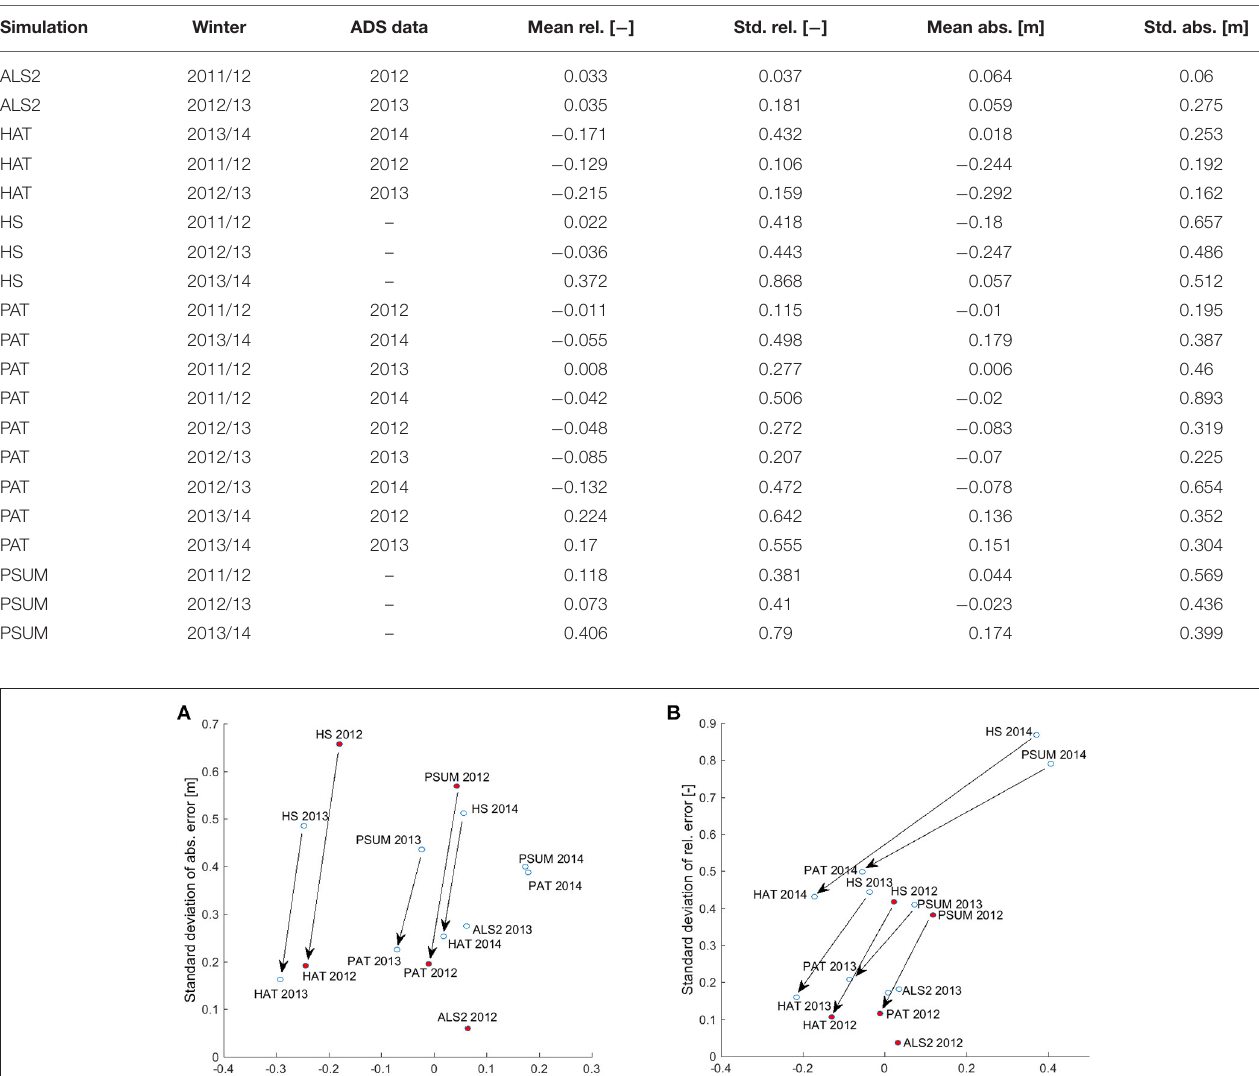
TABLE 2 | Overview on the statistics of the relative (rel) and absolute (abs) errors [mean and standard deviation (std)] for all simulations conducted. Simulation